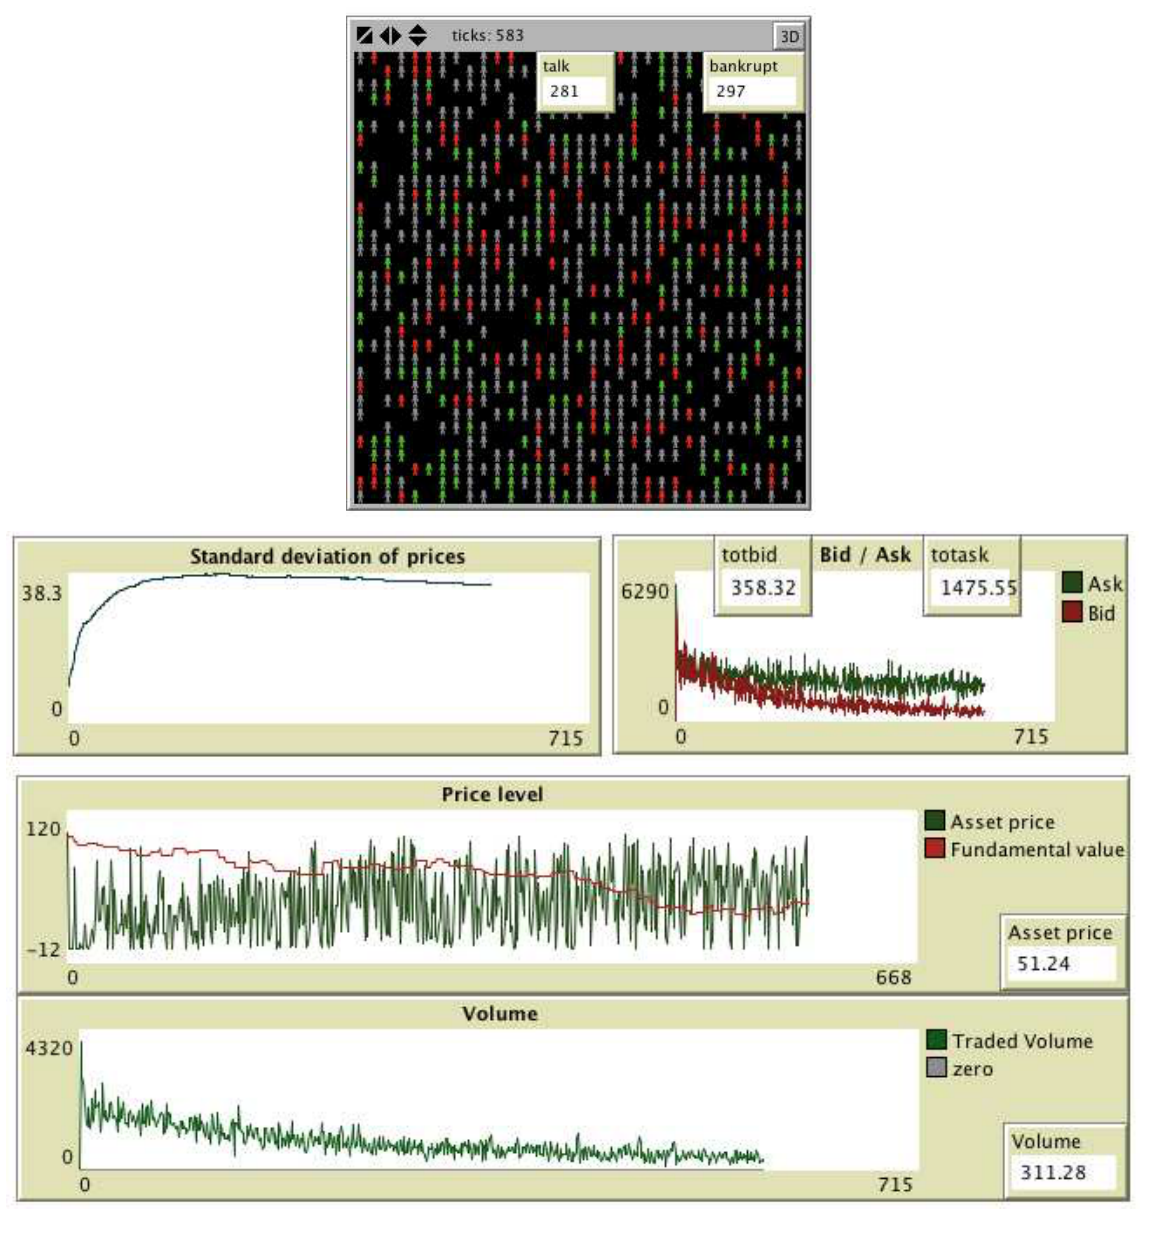
Figure 3. The evolution of stock market